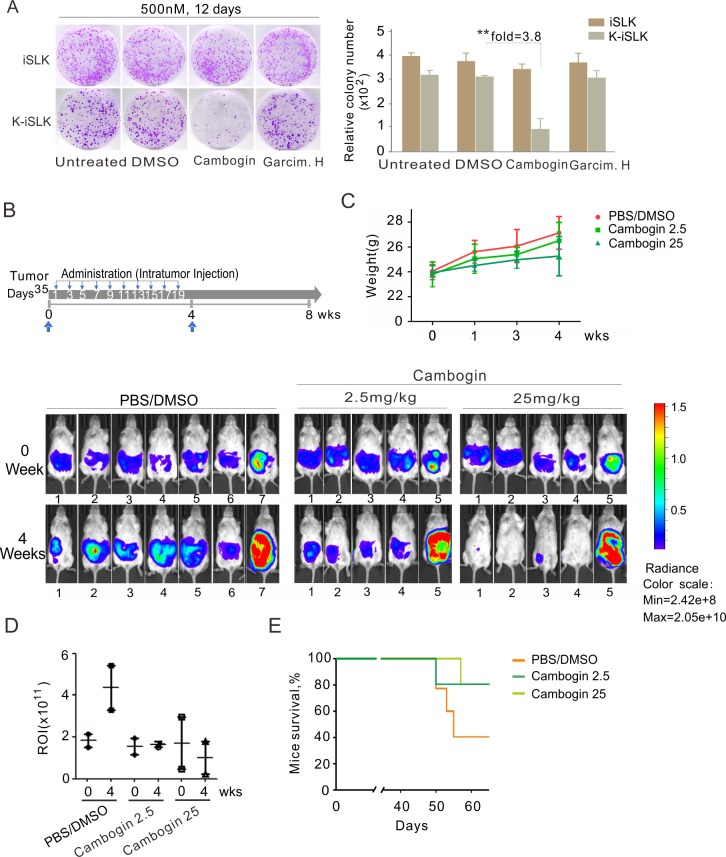
Cambogin significantly inhibits KSHV-latently infected cell growth in vitro and in vivo.(A) Cambogin selectively reduced the colony formation in KSHV-latently infected cells in vitro. Equal amounts of iSLK and KSHV-latently infected iSLK-K cells were individually inoculated and treated with or without Cambogin and Garcimultiflorone H and subjected to colony formation assays as indicated. The cells were fixed 12 days later and stained with crystal violet to determine colony number. A representative well with colony formation is shown. Right panel, the relative amount of colony formation was calculated from three independent experiments. Double asterisks indicate p<0.01. (B) Cambogin inhibited tumor progression in a xenograft mouse model of primary effusion lymphoma. The tumor burden of NOD/SCID mice was analyzed by luminescence assay at week 5 and then following treatment with PBS/DMSO, or Cambogin every other day for 3 weeks. Top panel, schematic of NOD/SCID mice intraperitoneally engrafted with ten million BCBL1-Luc cells for 35 days, and then untreated or treated with same amount of Cambogin every other day for 20 days. (C) Weights of NOD/SCID mice intraperitoneally engrafted with 107 BCBL-Luc cells for 5 weeks and then treated with Cambogin, every other day, for 3 weeks, were monitored every week. (D) Luminescent signals were quantified and expressed in region-of-interest (ROI) signal intensity [total radiant efficiency(p/s)/(μW/cm2)] in panel B. (E) Total percentage of mouse survival in each group is shown in panel B.